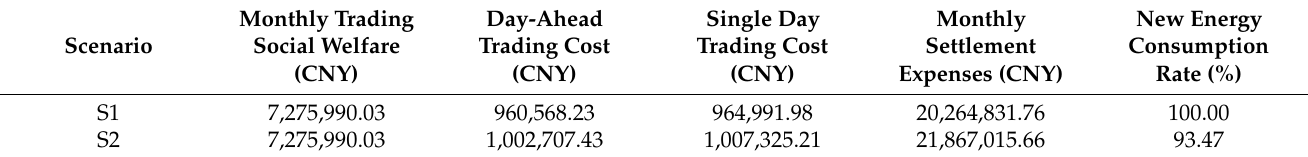
Table 2. Trading results in different scenarios.